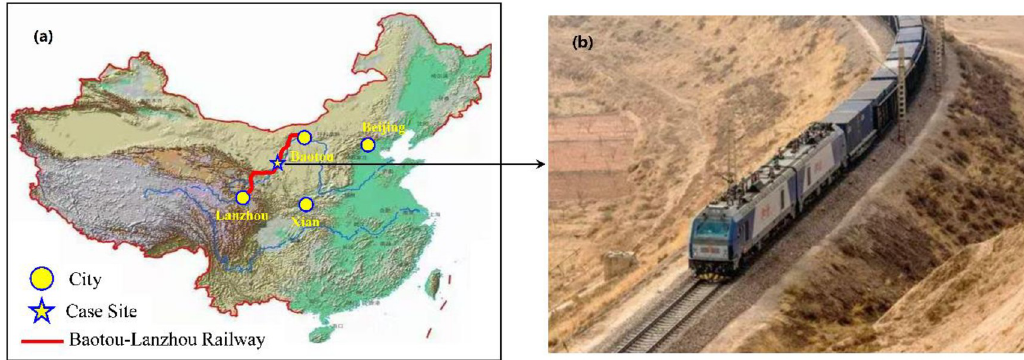
Fig 9. Trajectory of the Baotou-Lanzhou railway (a) and an overview of train running on this route (b).